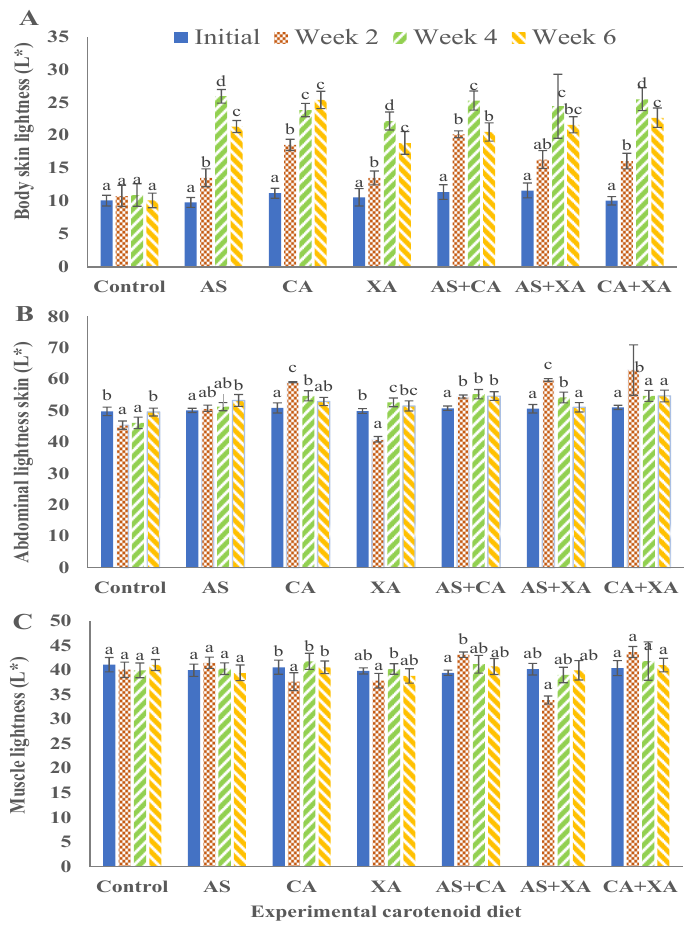
Figure 4. Lightness for body skin ( A ), abdominal skin ( B ), and muscle ( C ) of bighead catfish fed dietary pigments for 2, 4, and 6 weeks. Astaxanthin (As), ccanthaxanthin (Ca), and xanthophyll (Xa). (a, b, c) Average values of different diets at the same sampling time with different letters are significantly different ( p < 0.05). Each bar is the mean value of three replicates, three fish per replicate.